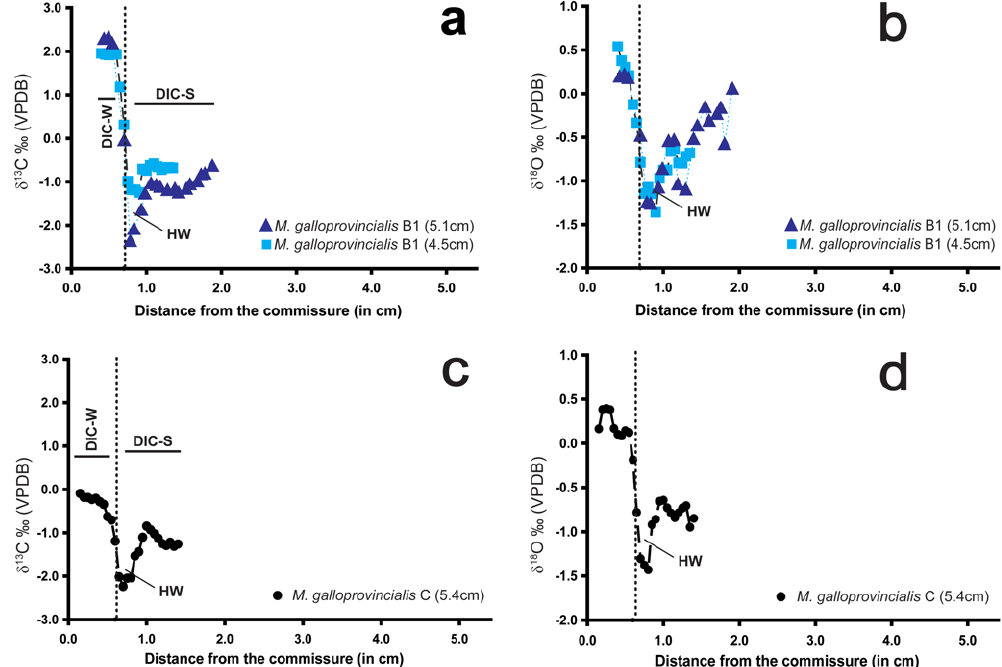
Fig. 10. Times series δ 13 C and δ 18 O ratios plotted against distance from shell commissure. Different specimens/shells are labelled according to shell length. Mytilus galloprovincialis C (5.4cm) refers, for example, to a specimen with shell length of 5.4cm transplanted from the harbour to the control site C. ( a and b ) Horizontal, black stippled line separates data from shell material precipitated before (right) and after (left) transplantation. Note considerable negative excursion in both carbon and oxygen data in August 2009 followed by marked positive trend until December 2009. Negative δ 18 O shift is probably best interpreted as effect of an anomalous warm and long heat-wave (HW). Positive shift is only in part related to temperature alone and is probably related to seawater pH change and metabolic effects. DIC-S refers to seawater δ 13 C DIC value during summer 2009 and DIC-W the δ 13 C DIC value of seawater during winter 2009. ( c and d ) Data from M. galloprovincialis C showing transition from Ischia harbour to normal pH control site C. Near identical isotope pattern as recorded at site B1 is found albeit with smaller